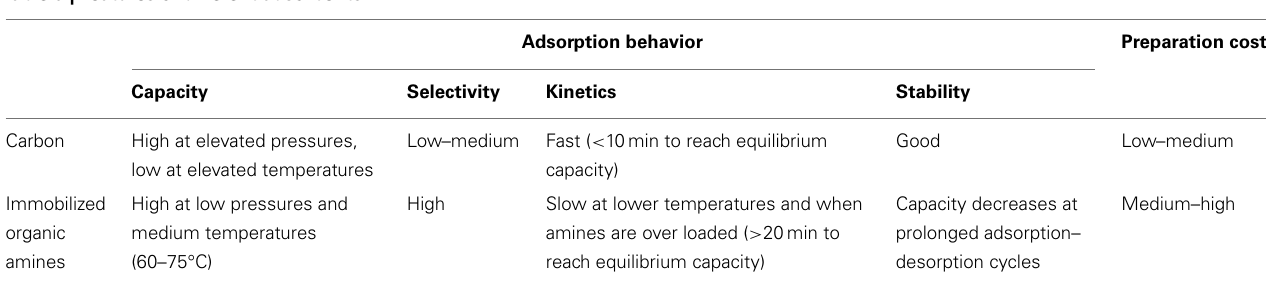
Table 5 | Features of different adsorbents